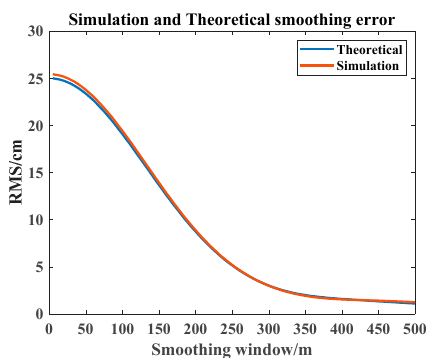
Figure 10. Original sea surface smoothing error (in cm). The SWH is selected as 2 m and the pixel size is 5 m×5 m. The smoothing window is a square window.